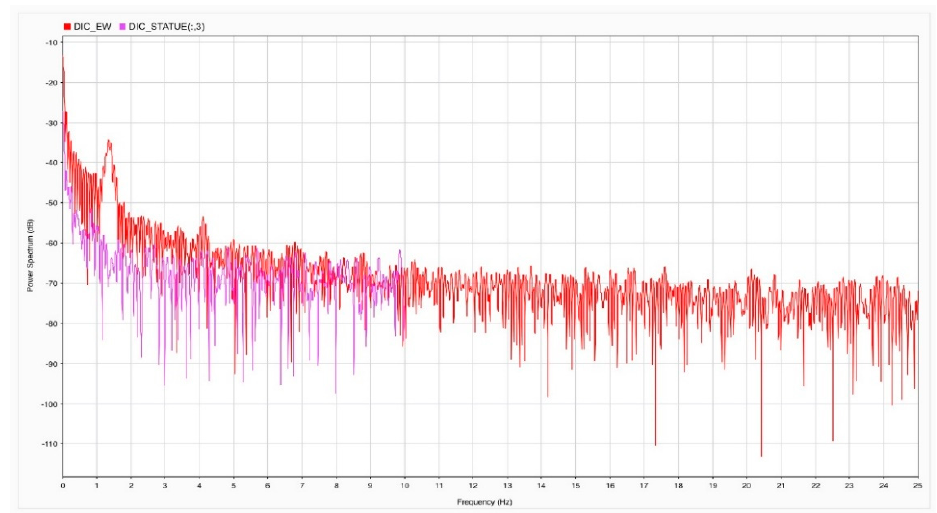
Figure 22. Comparison DIC analysis on the gantry (red) and the statue (light purple) [22]. A step further than Schumacher and Shariati [20] was completed in this work. In particular, a Virtual Visual Sensor (VVS) method was used, not only to accurately calculate the fundamental vibration frequency of s’s DOF (single-degree-of-freedom), but also as a multi-degree-of-freedom (MDOF) and continuous systems as the gantry is [19]. Furthermore, frequency and amplitude of vibration were given. It is worth mentioning that integrating results from monitoring using TInRAR technique and PhotoMonitoring allows for characterizing displacement on three perpendicular axes: the direction of the LOS for